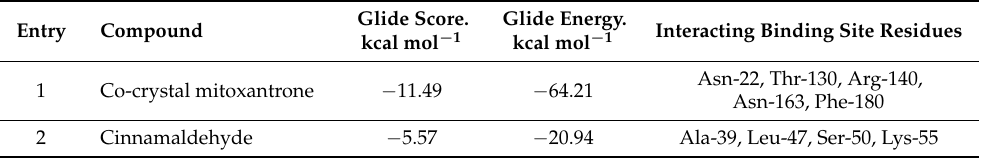
Figure 10. Surface view ( up ) and 3-D structure view ( down ) of co-crystalized mitoxantrone in the active site of PknB. Table 4. Summary of the binding affinities of co-crystalized mitoxantrone and cinnamaldehyde molecules in terms of docking scores and glide energies generated by GLIDE XP